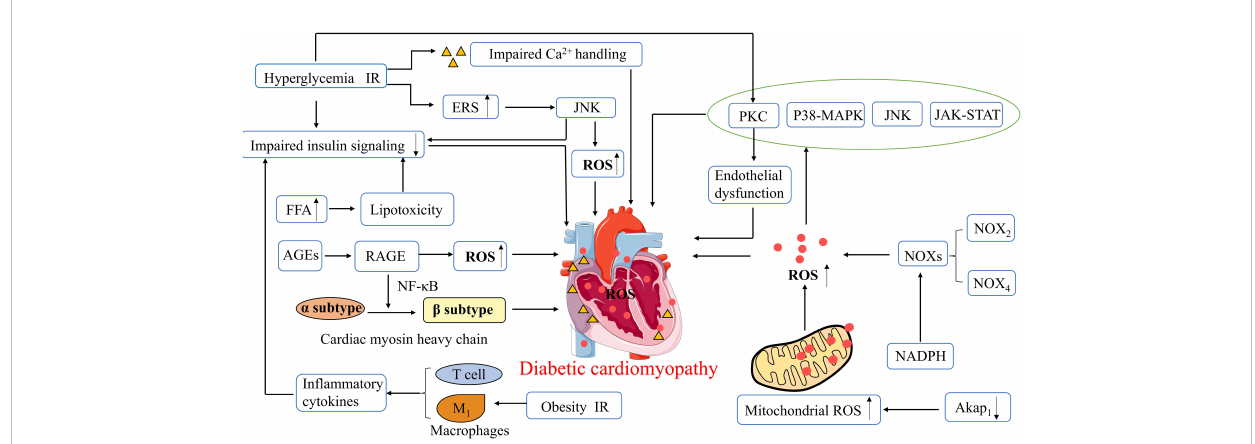
FIGURE 2 Pathophysiological mechanisms of diabetic cardiomyopathy. ROS, Reactive oxygen species; ERS, Endoplasmic reticulum stress; PKC, protein kinase C; p38 MAPK, p38 Mitogen activated protein kinase; JNK, Jun kinase; JAK -STAT, Janus kinase and signal transducer and activator of transcription; NADPH, Nicotinamide adenine dinucleotide phosphate; NOXs, NADPH Oxidases; Akap 1 , A-kinase anchoring protein 1; FFA, Free fatty acids; AGEs, Advanced glycation end-products; RAGE, AGE receptor; NF- k B, nuclear factor- k B; IR, Insulin